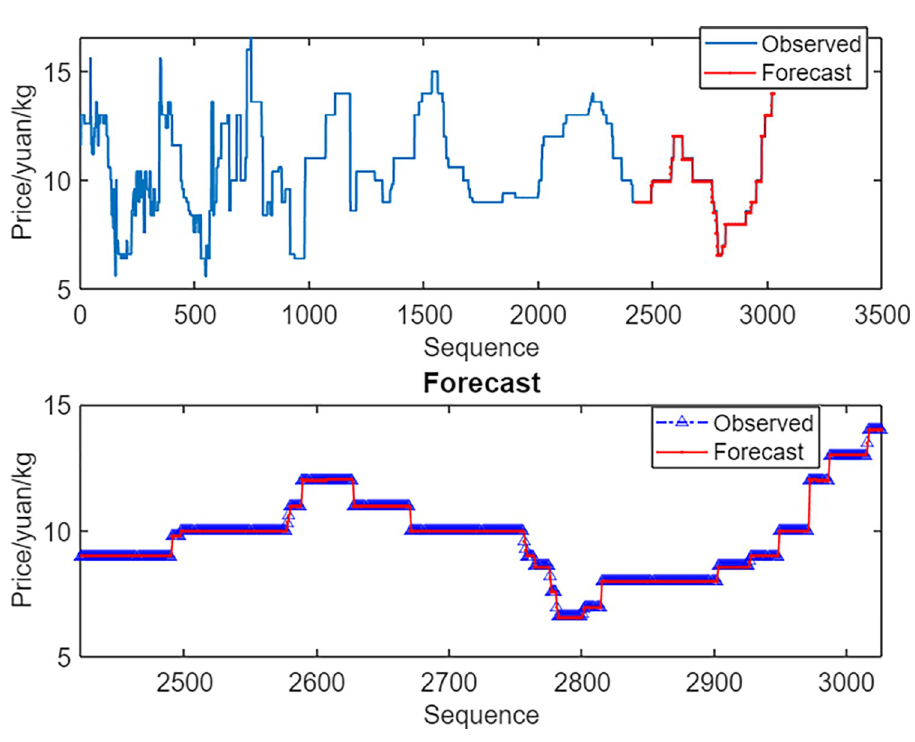
Fig 9. BP-LSTM model prediction results.